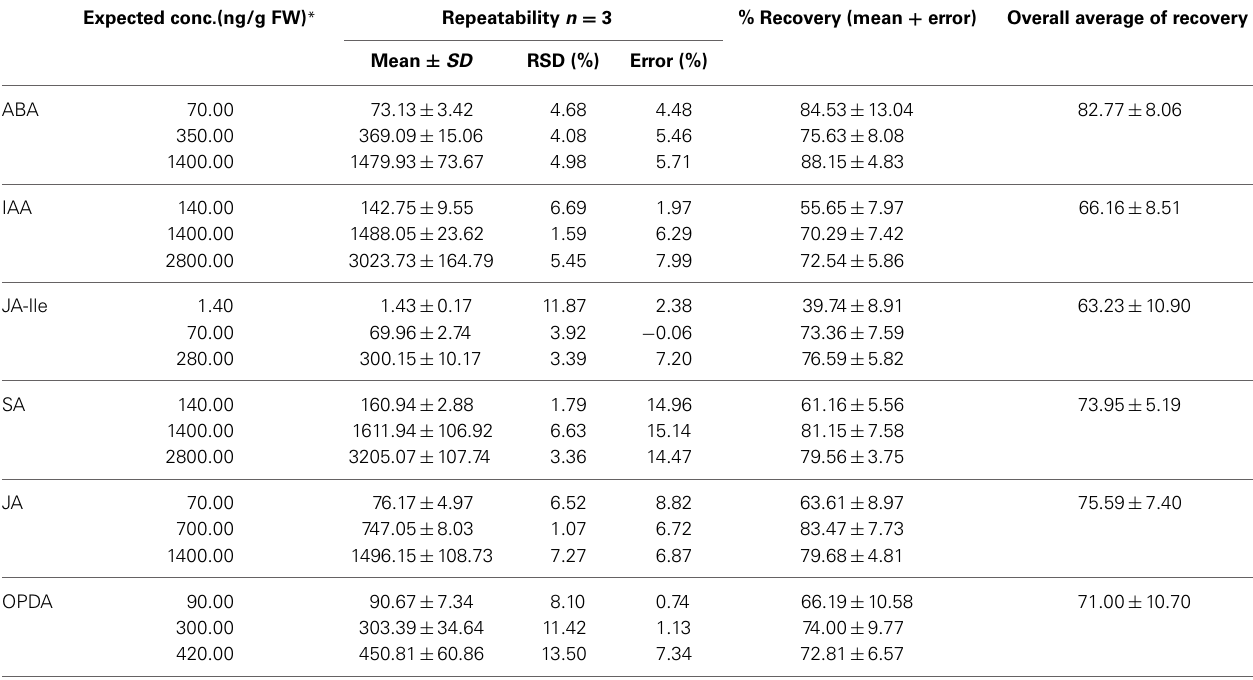
Table 6 | Values of repeatability (accuracy and precision) obtained during the validation of the method for quantification of various phytohormones (ABA, IAA, JA-Ile, SA, JA, and OPDA) in leaves of Citrus sinensis . Expected conc.(ng/g FW)